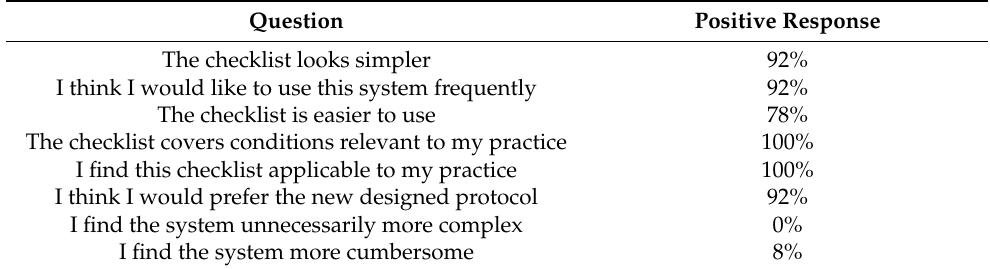
Table 4. Police officers’ responses to questions comparing the redesigned checklist withthe